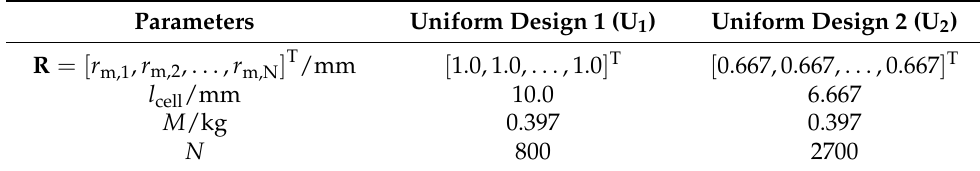
Table 1. The parameters of uniform design models.